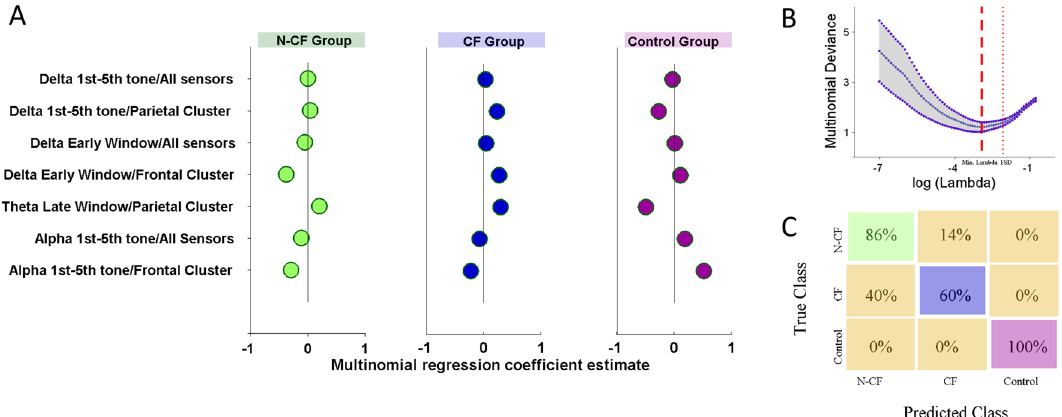
Figure 4. Coefficient estimates for a penalised multinomial logistic regression. ( A ) Spatiotemporal variables and their coefficients selected from the regularised multinomial model. ( B ) The method leaves out a subject from the sample, fits the model for 100 different λ values, and computes the goodness-of-fit error for each λ value. Red lines show the optimal degree of penalisation (lambda) related to the minimum value of multinomial deviance and one standard deviation. ( C ) Confusion matrix showing the percentage of predicted and true classes estimated by multinomial regression coefficients across the 3